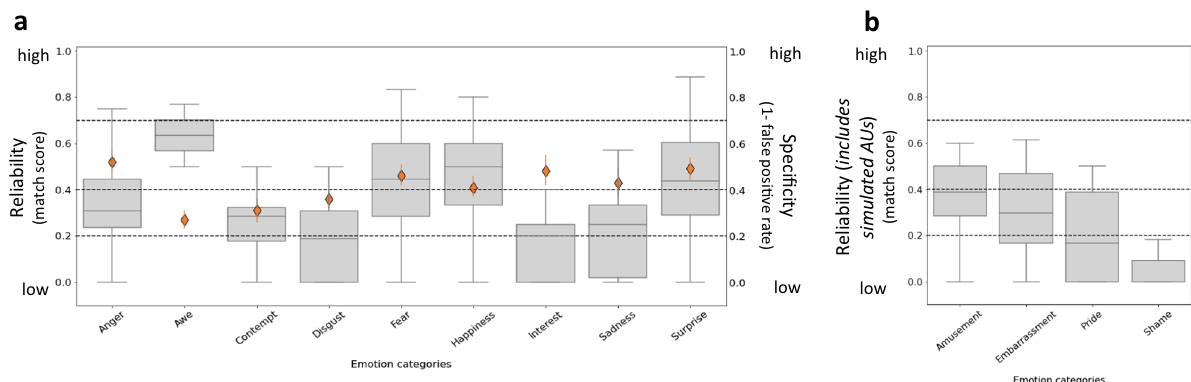
Fig. 3 Reliability and speci fi city of hypothesized facial con fi gurations in each emotion category. a Emotion categories for which all action units (AUs) were available to be coded. b Emotion categories for which AUs were simulated, given that dynamic AUs could not be coded from photographs. Reliability: The gray box-and-whisker plots show the distribution of match scores between the facial poses and hypothesized facial con fi gurations for each emotion category. Each plot presents the maximum and minimum values as whiskers, the interquartile range as the vertical length of the box, and the median as the horizontal line within the box. The dotted horizontal lines denote the degree of reliability, based on criteria from prior research 35 : none (0 < 0.2), weak (0.2 < 0.4), moderate (0.4 < 0.7), high (0.7 ≤ 1). Speci fi city: The orange diamonds represent the proportion of facial poses ( N = 604) matching the hypothesized facial con fi guration for each emotion category that were observed in response to scenarios classi fi ed as the same emotion category, calculated as the complement of the false positive rate ð c p e Þ , such that higher scores indicate greater speci fi city. Error bars represent estimated credibility intervals. We were not able to compute speci fi city for the emotion categories amusement, embarrassment, pride, or shame because we did not have information about dynamic AUs, which constitute part of the hypothesized facial con fi gurations for these categories. Source data are provided in Supplementary Tables 7 and